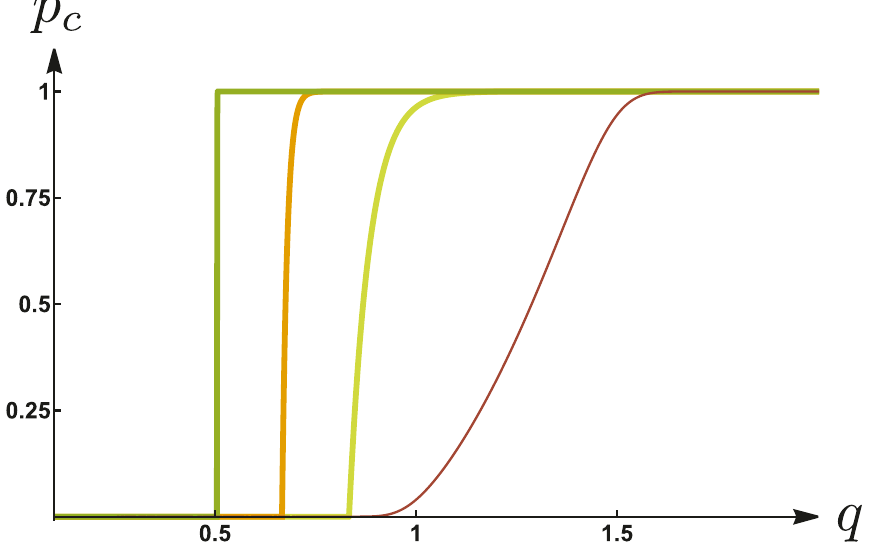
Figure 10 . Analytic plot of p c ( m, q ) for m = 1 . 5 (yellow), m = 3 (orange) and m = 100 (green) and numerical plot for m = 0 . 7 (thin, brown) as a function of q = βs k the ( m, 1) Renyi reflected entropies undergo a transition changes as a function of m for m > 1